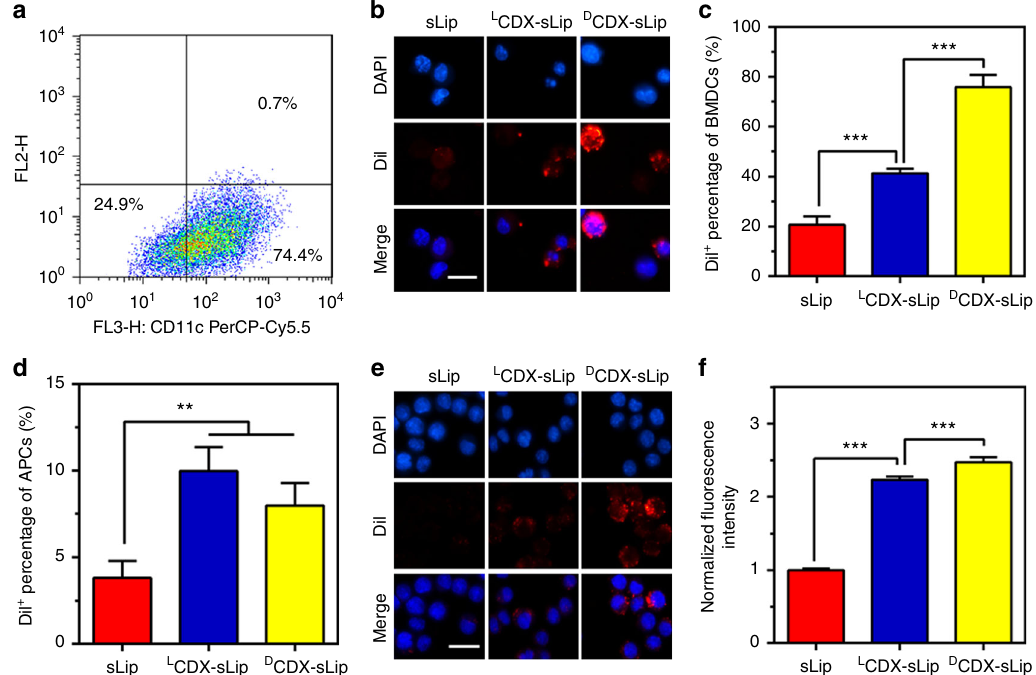
Fig. 2 The uptake of sLip, L CDX-sLip, and D CDX-sLip by APCs. a The ratio of CD11c + cells in BMDCs. BMDCs were stained with anti-CD11c antibody and counted by fl ow cytometry. b Microscopy observation of DiI + BMDCs by confocal laser scanning microscopy. BMDCs were cultured with DiI-loaded liposomes for 4 h with serum and the nuclei were stained with DAPI. c The ratio of DiI + BMDCs counted by fl ow cytometry. d The ratio of DiI + cells in MHC II + APCs. Lymph nodes were isolated 12 h post injection, then suspended in PBS. Cell suspension was incubated with anti-MHC II antibody at 4 °C for 1 h and the ratio of DiI + cells in MHC II + APCs was counted by fl ow cytometry. e Microscopy observation of DiI + macrophages by confocal laser scanning microscopy. RAW264.7 cells were cultured with DiI-loaded liposomes for 1 h with serum and the nuclei were stained with DAPI. f The normalized fl uorescence intensity in RAW264.7 cells by fl ow cytometry. Scale bar = 20 μ m, n = 3, data are means± s.d. Statistical signi fi cances were calculated by Student ’ s t -test. ** p < 0.01, *** p < 0.001